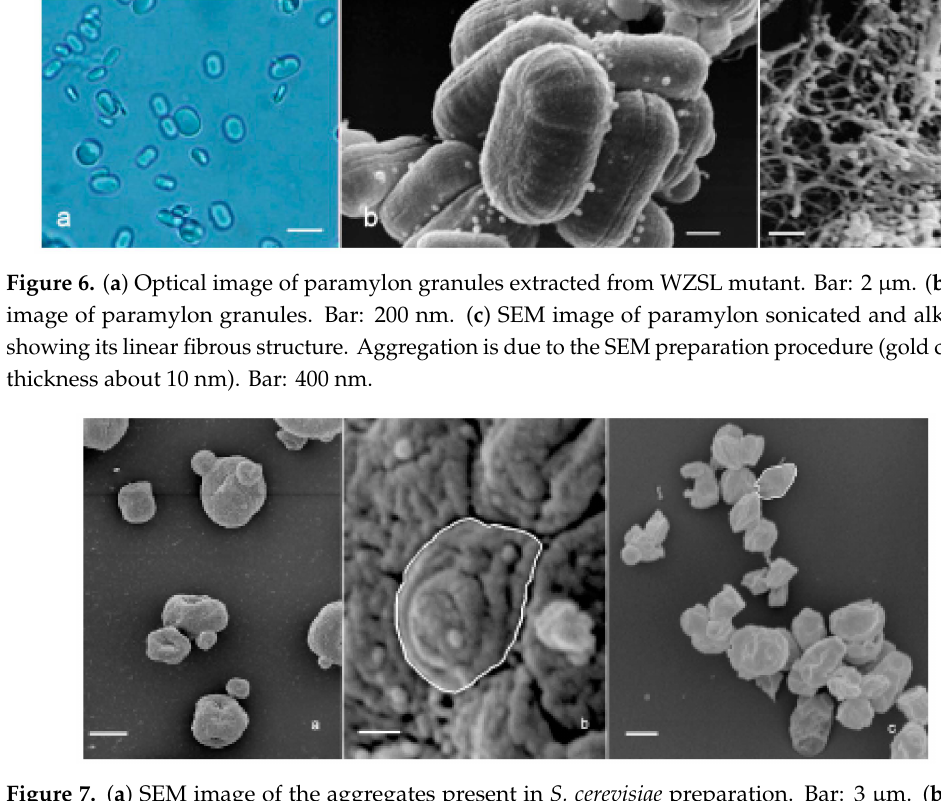
Figure 7. ( a ) SEM image of the aggregates present in S. cerevisiae preparation. Bar: 3 µ m. ( b ) SEM image of an aggregate surface showing its particulate texture. The white contour defines a single particle. Bar: 200 nm. ( c ) SEM image of the irreducible particles. The white contour defines a single particle. Bar: 1 µ